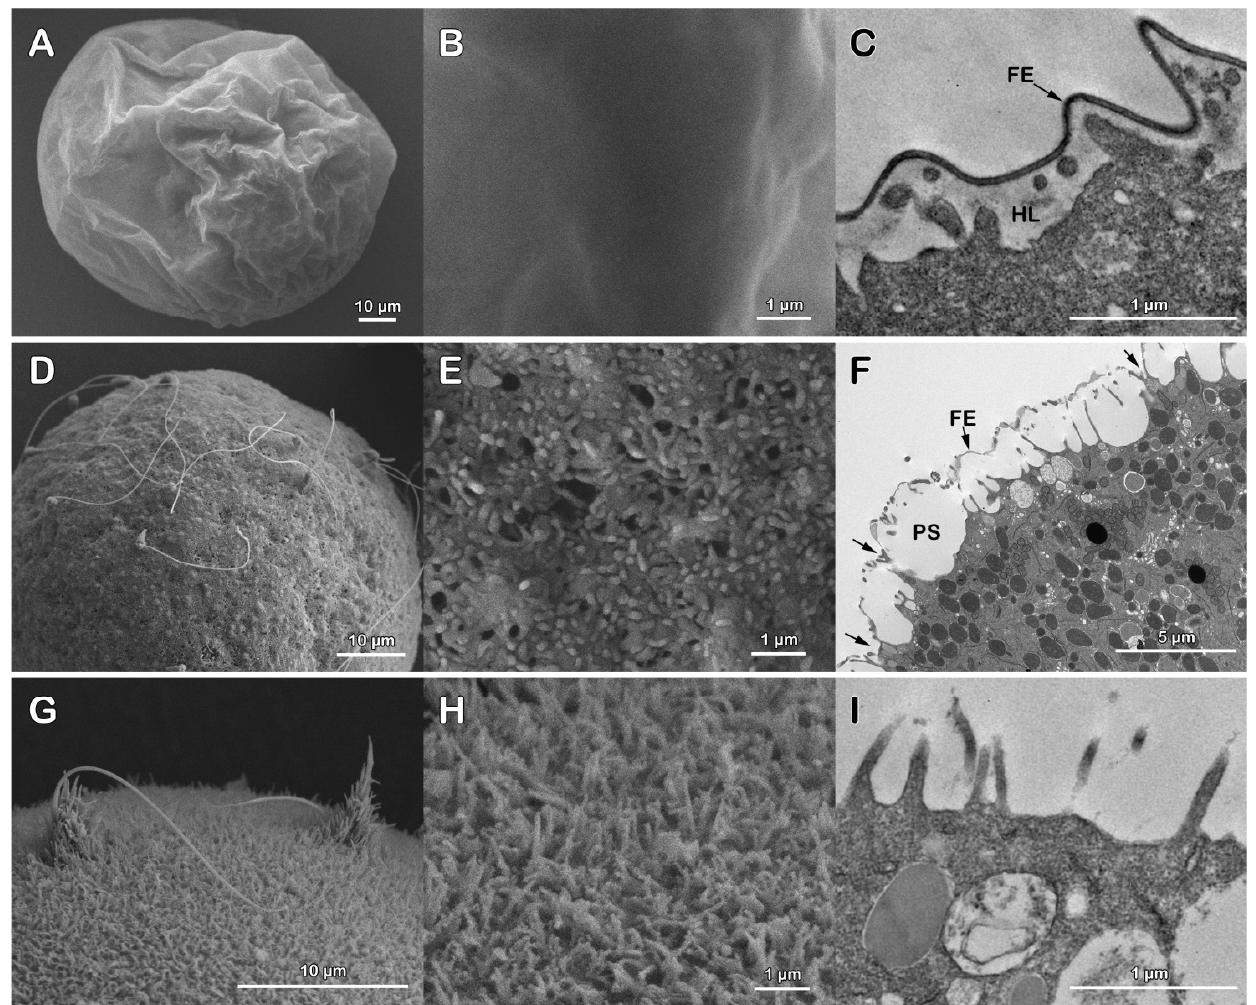
Figure 2. Effect of acidic seawater and DTT treatment to remove the vitelline layer on the cortical reaction of P. lividus eggs at fertilization. The SEM micrographs ( A , B ) show at a lower and higher magnification the fertilization envelope (FE) 5 min after insemination of a control egg in NSW (pH 8.1). At this time of the fertilization process, the continuous and thick FE, as a result of the exocytosis of the cortical granules (CG) in the perivitelline space (PS), is well evident in the TEM image in ( C ). Long microvilli embedded in the hyaline layer (HL) are visible. An alteration of the cortical reaction is evident in both SEM ( D , E ) and TEM micrographs (F), showing the surface of a P. lividus egg incubated for 5 min in acidic seawater and inseminated in the same medium. The eggs were fixed 20 min after sperm addition. Note in ( D ) that at this time of the fertilization process, the sperm were still bound to the FE, whose structure was heavily altered by the shrinking effect of the acidic seawater on the structural organization of the egg surface and cortex. At variance with the control, the thinner FE surrounding the fertilized egg in the TEM image in ( F ) was ruptured and failed to fully elevate from the egg surface due to its attachment with the elongated microvilli (arrows) in the perivitelline space (PS). The SEM micrograph in ( G ) shows the long microvilli of the fertilization cones engulfing two sperm on the surface of an egg deprived of both the vitelline layer and egg jelly by the DTT treatment prior to insemination. Note that the absence of the elevation of the FE in the SEM ( H ) and TEM ( I ) images allowed the visualization of the elongation of microvilli (MV) which usually occurs in the perivitelline space. See Figure 2A–C for comparison with the con- trol.